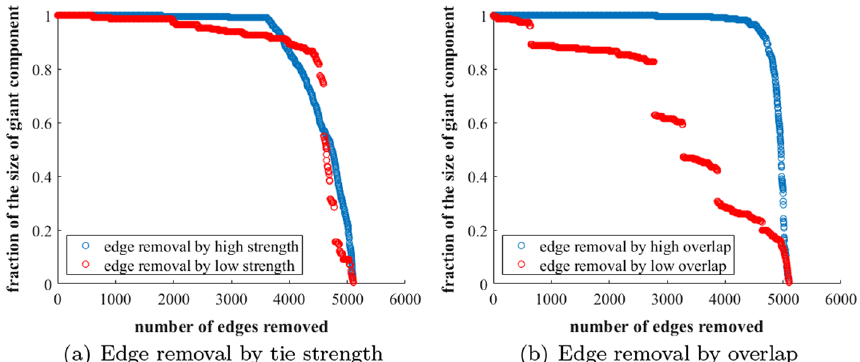
Fig. 5 Change of the size of the giant component with edge removal. In both figures, the blue points correspond to removing the edge with the highest strength or overlap each time. The red points correspond to removing the edge with the lowest strength or overlap each time. The gaps between the red points indicate that removing edges with low strength or overlap will break down the graph and induce smaller